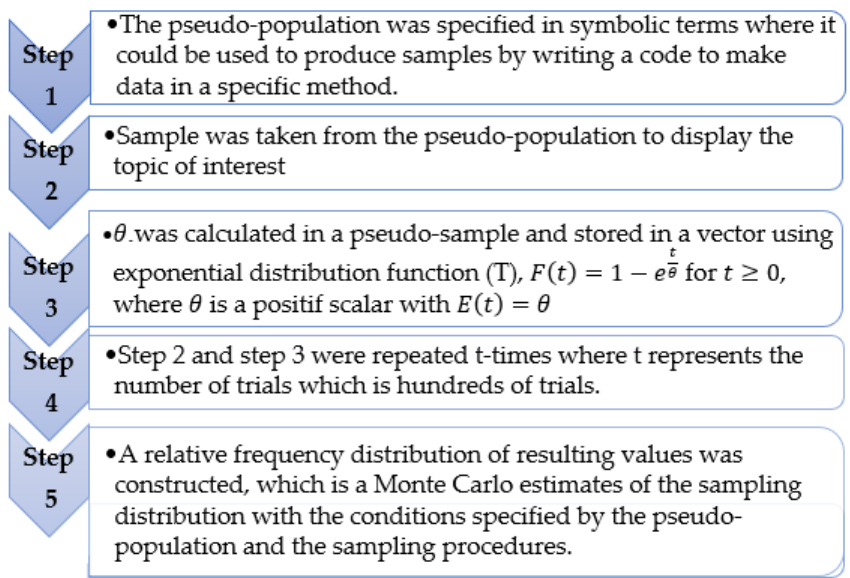
Figure 6. Procedure using RPCA-FCM.